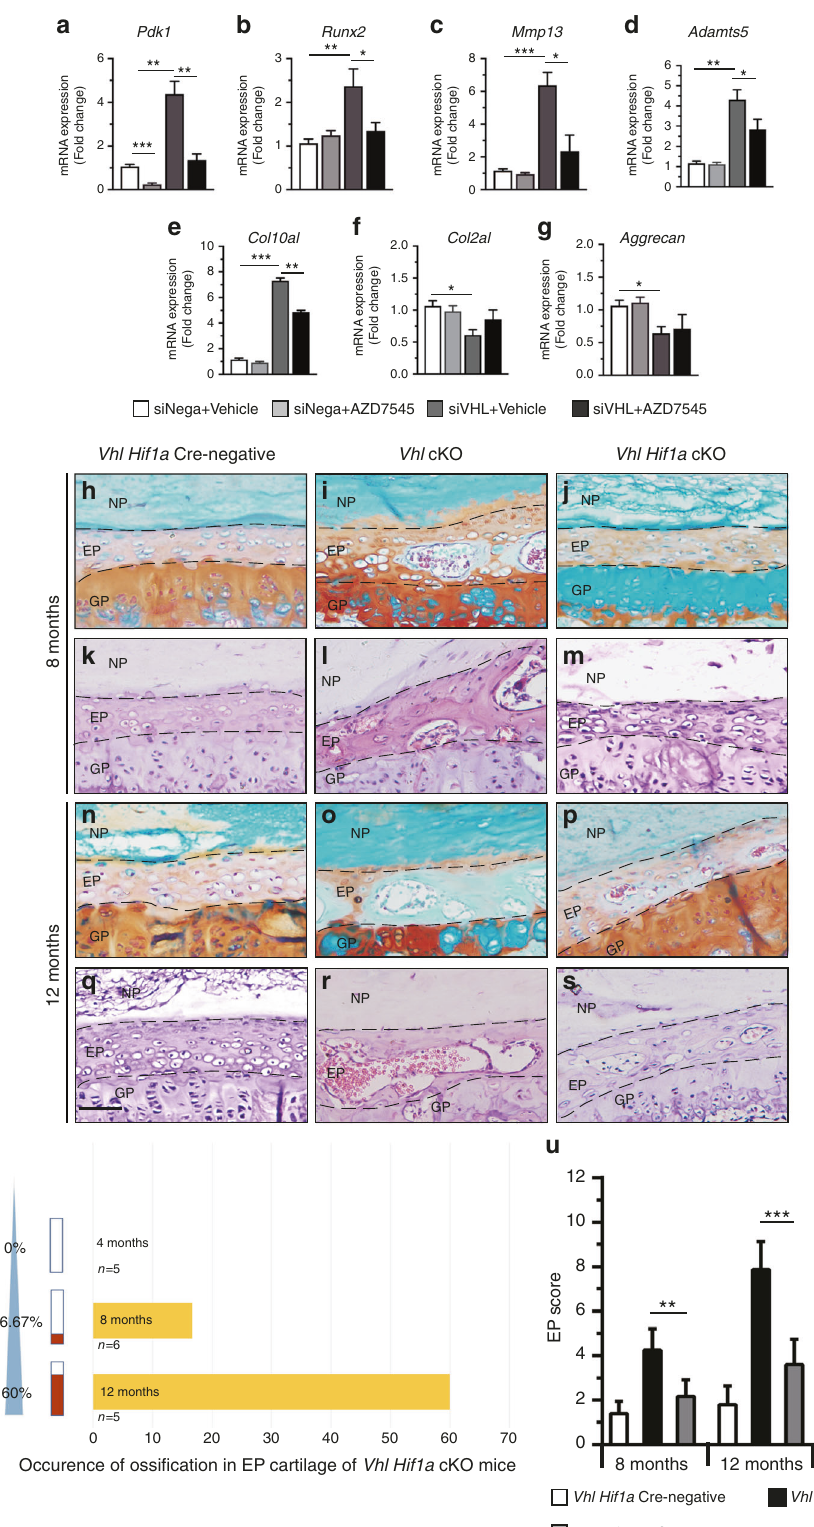
Fig. 7 Genetic ablation of the Hif1 α gene delays DDD pathogenesis. a – g RCS cells were transfected with siRNA-Vhl (RCS-siRNA-Vhl), followed by treatment with ADZ7545 (10 μ mol·L − 1 ). Total RNA was isolated, and the mRNA levels of Pdk1 , Runx2 , Mmp13 , Adamts5, Col10al , Col2al, and Aggrecan were detected by RT-PCR ( n = 3 per group). h – s Representative Fast green/Safranin O- and H&E-stained images of EPs from WT, Vhl cKO, and Vhl Hif1 α cKO mice ( n = 6 – 8 per group). t Occurrence of ossi fi cation in EP cartilage of Vhl Hif1 α cKO mice. u Degenerative scores of EP cartilage in WT, Vhl cKO, and Vhl Hif1 α cKO mice. Scale bar: 50 µm ( a – l ). Data are expressed as the percent expression relative to controls. Values represent the mean (symbols) ± SD (error bars). * P < 0.05; ** P < 0.01; *** P <